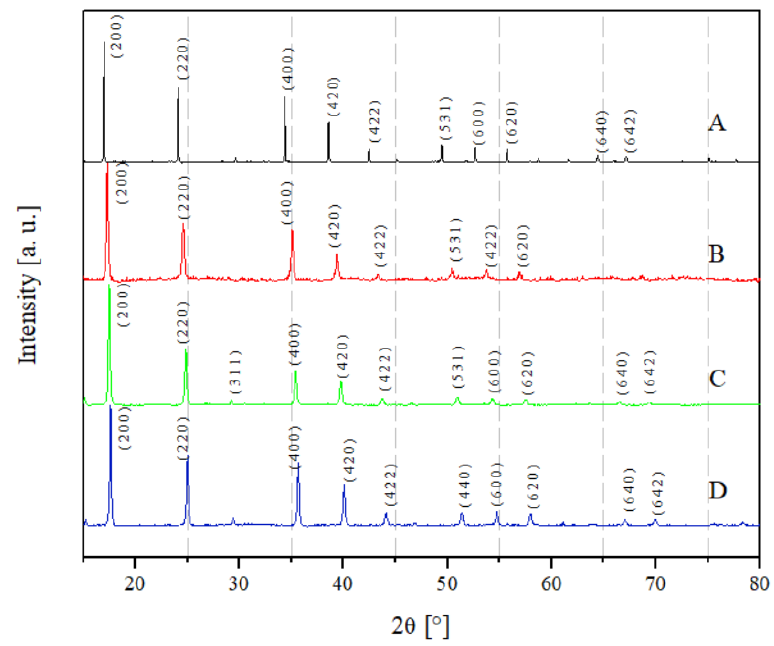
Figure 6. X-ray di ff raction (XRD) spectra of (A) Mn–Co, (B) Co–Co, (C) Ni–Co, and (D) Cu–Co Figure 6. X-ray diffraction (XRD) spectra of A) Mn–Co, B) Co–Co, C) Ni–Co, and D) Cu–Co catalysts.